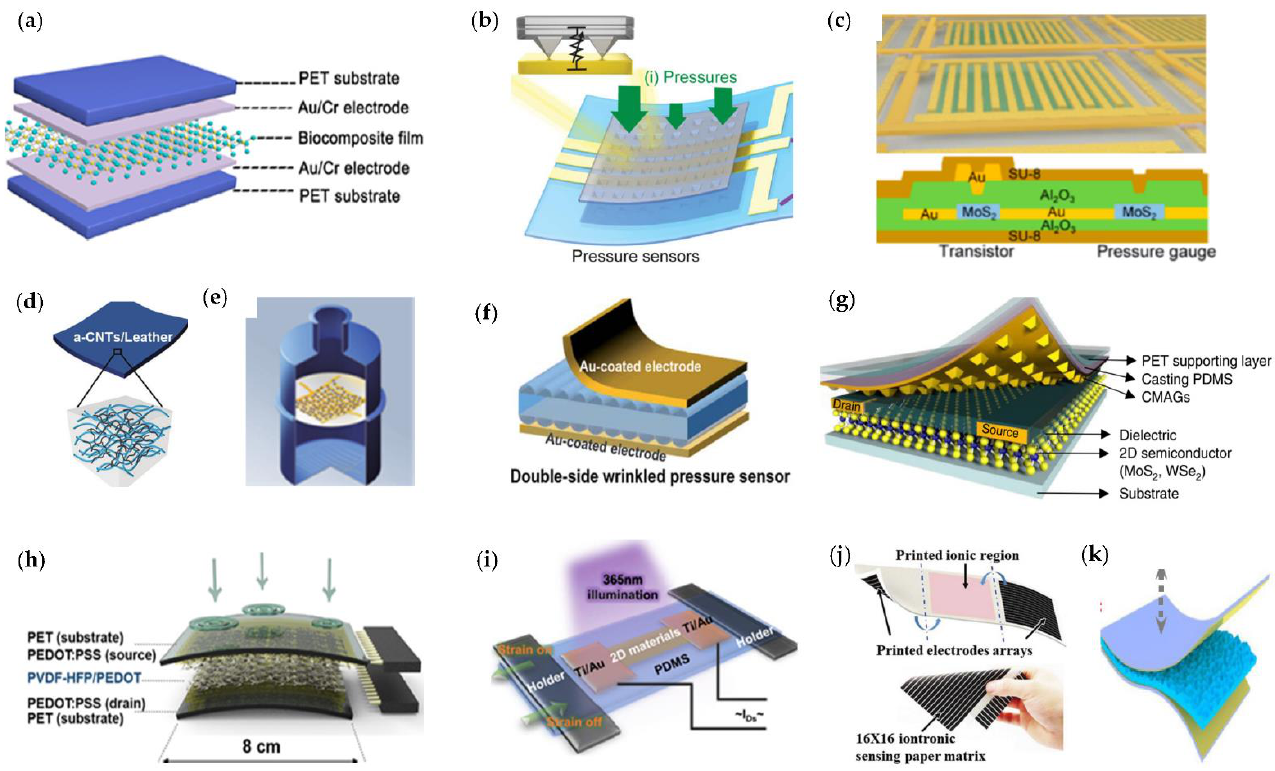
Figure 4. Several typical pressure sensor structures. ( a ) Schematic illustration of biocomposite film-based flexible